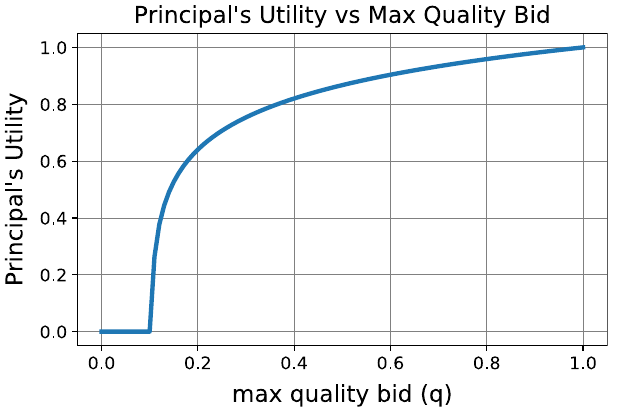
Figure 2. The auctioneer’s utility function: max ( log ( a ( q − b )) , 0 ) .